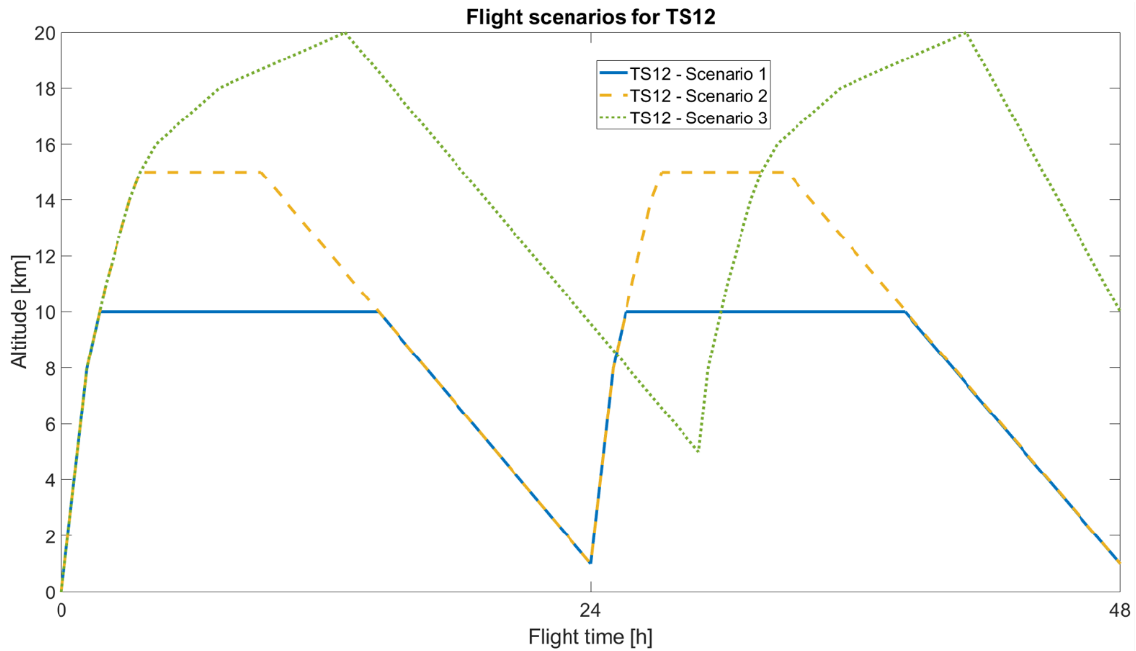
Figure 12. Flight scenarios for TS12.